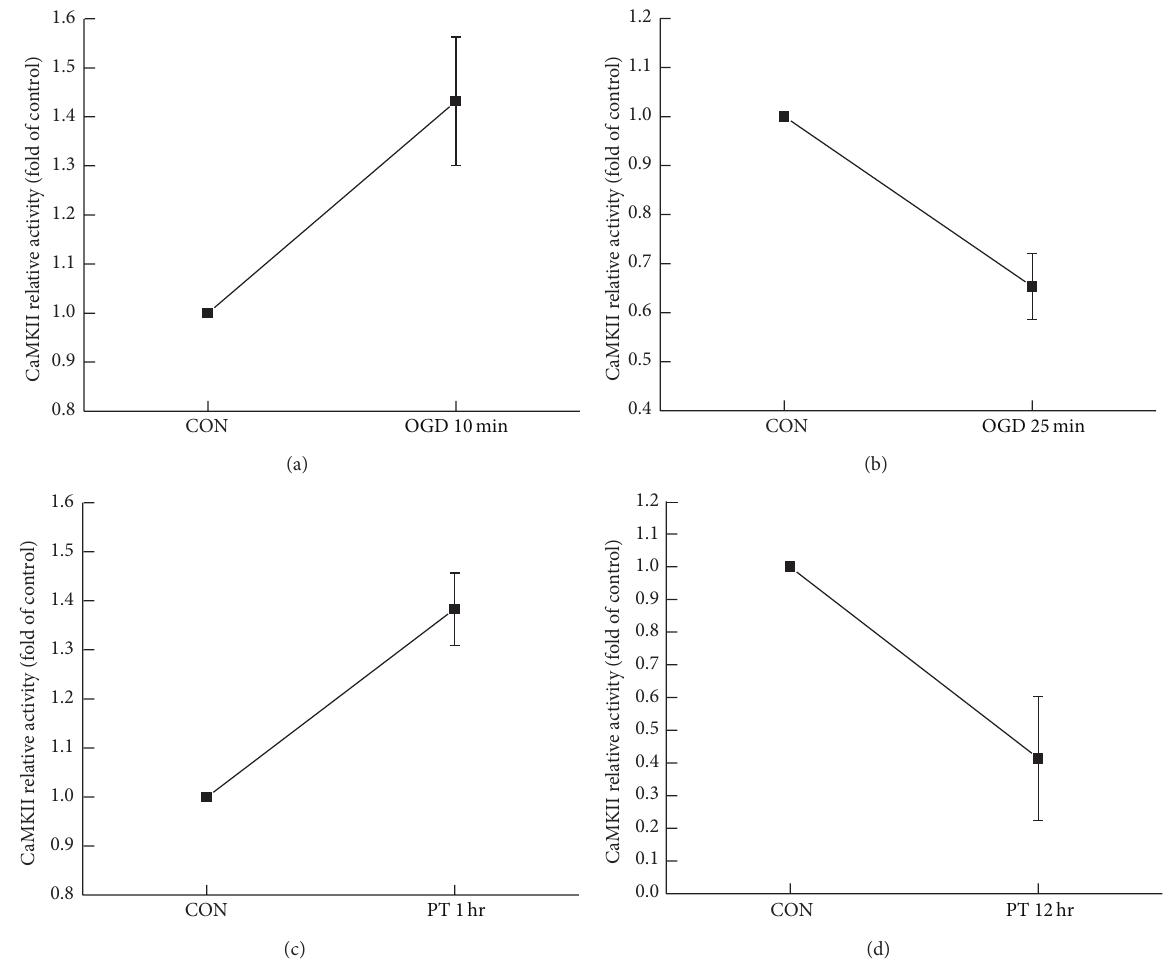
Figure 3: (a) OGD for 10 min caused a significant increase in CaMKII activity ( 1.43 ± 0.13 , 𝑛 = 4 , 𝑃 < 0.05 ). (b) OGD treatment for 25 min led to inhibition of CaMKII activity ( 0.65 ± 0.07 , 𝑛 = 3 , 𝑃 < 0.05 ). (c) 1hr after PT, CaMKII activity displayed an upward trend ( 1.38 ± 0.07 , 𝑛 = 3 , 𝑃 < 0.05 ). (d) 12 hr after PT, CaMKII activity was inhibited ( 0.41 ± 0.19 , 𝑛 = 3 , 𝑃 < 0.05